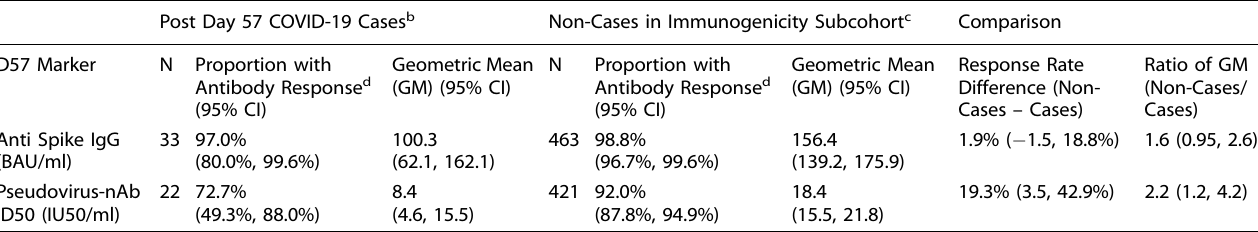
Table 1. D57 antibody marker a SARS-CoV-2 seroresponse rates and geometric means by COVID-19 outcome status.